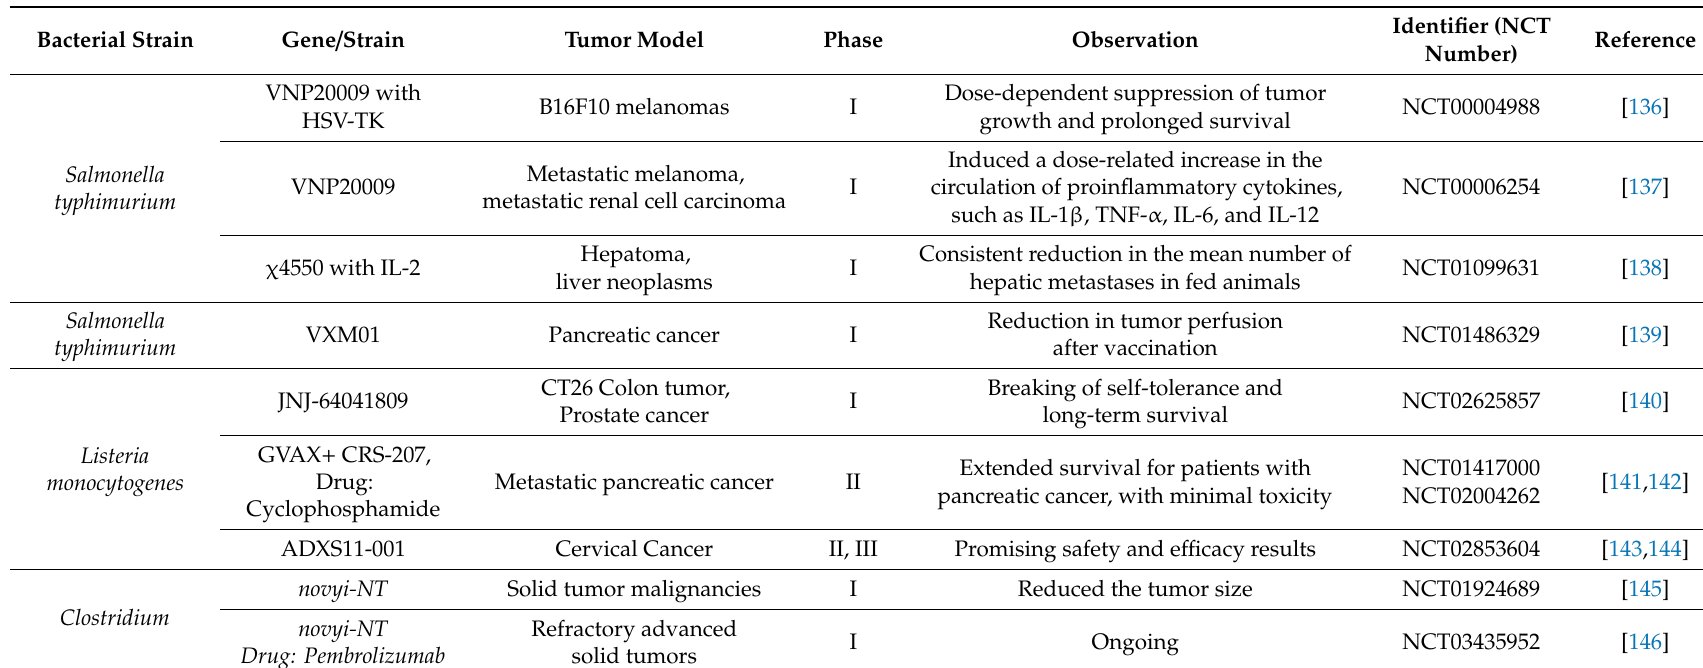
Table 3. Summary of the active clinical studies focused on bacterial mediated anti-cancer therapy